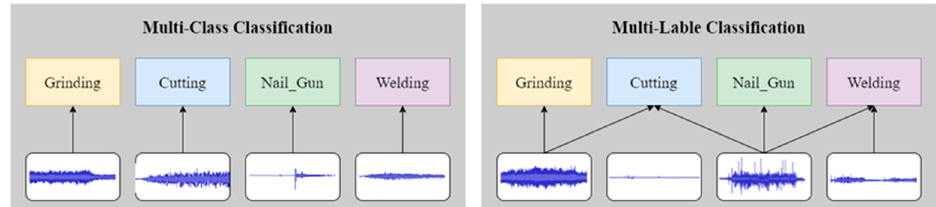
Figure 1. The difference between multi-class and multi-label classifications.